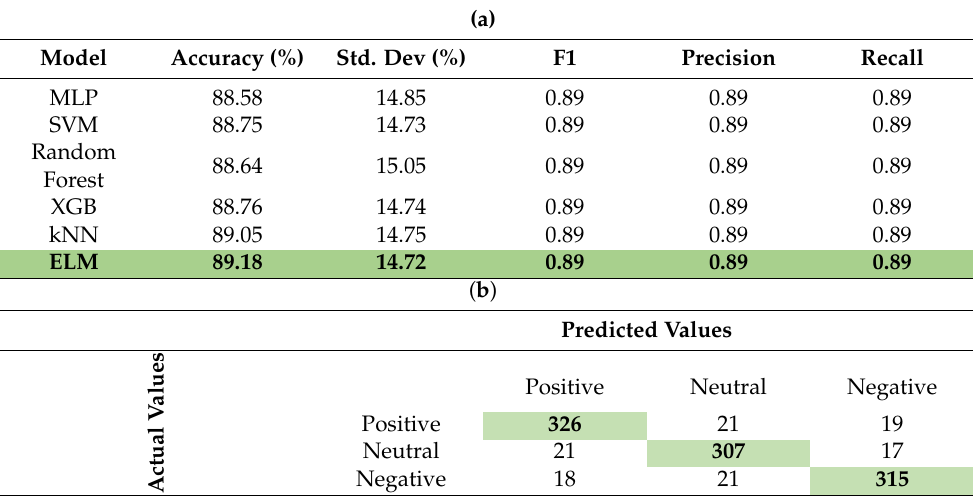
Table 5. ( a ). SEED (3 classes) results for CNN hybrid models. ( b ). Confusion matrix of 3D-CNN and ELM classifier for SEED dataset.